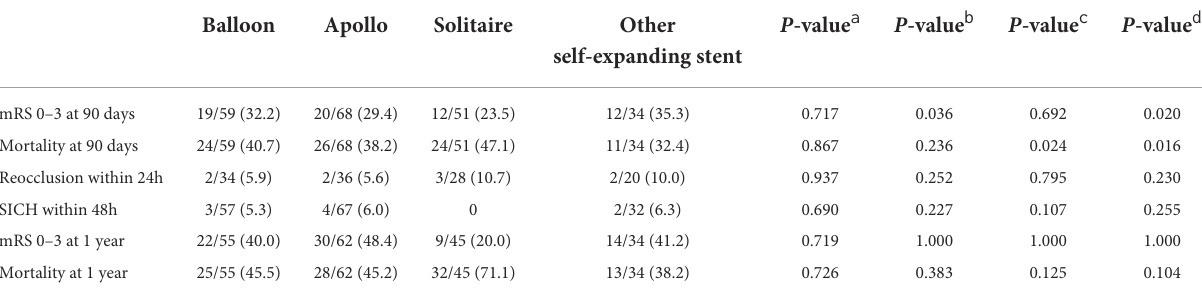
TABLE 4 Comparison of clinical outcomes among patients rescued with different rescue measures. Balloon